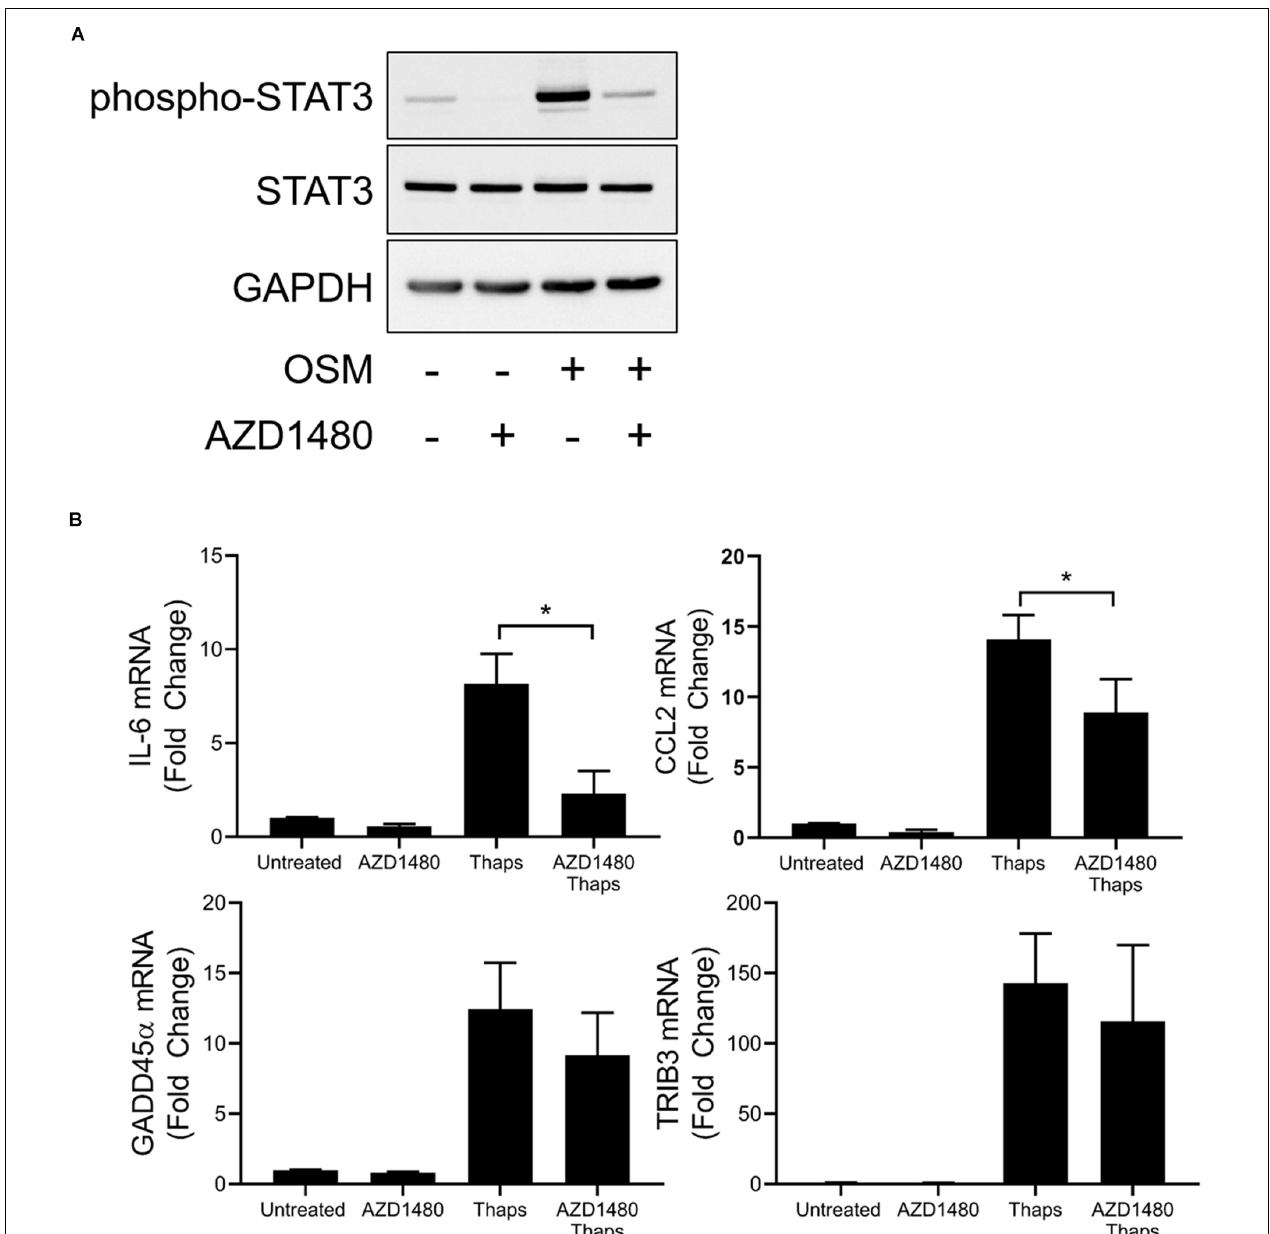
FIGURE 6 | A subset of ER stress-induced JAK1-dependent signaling is insensitive to kinase inhibition of JAK1. (A) Astrocytes were pretreated with JAK1/2 kinase inhibitor AZD1480 (1 µ M) for 1 h before 0.5 h treatment with oncostatin M (OSM). Protein lysates were collected and analyzed by immunoblot. (B) Astrocytes were pretreated with AZD1480 for 1 h and then treated with thaps for 4 h. Gene expression was analyzed by RT-qPCR. Data are represented as means ± standard deviation. N = 3. ∗ p <